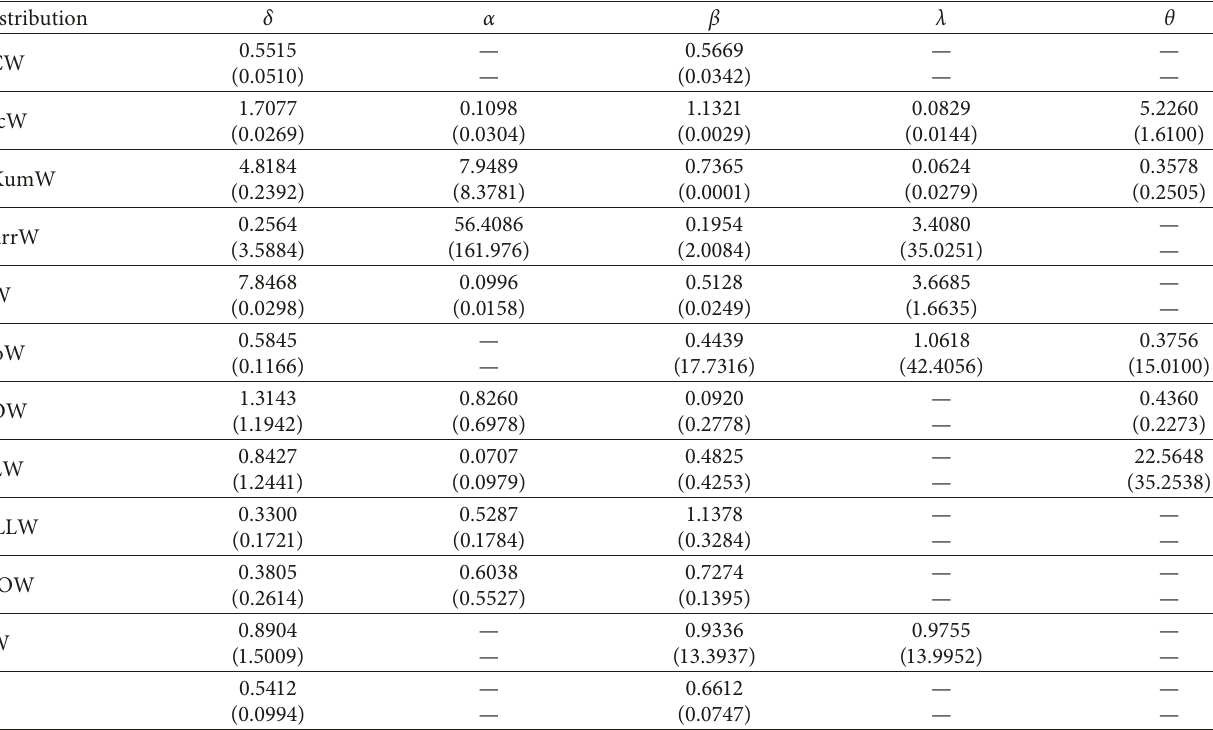
Table 5: MLEs and their standard errors (in parentheses) for failure time data.